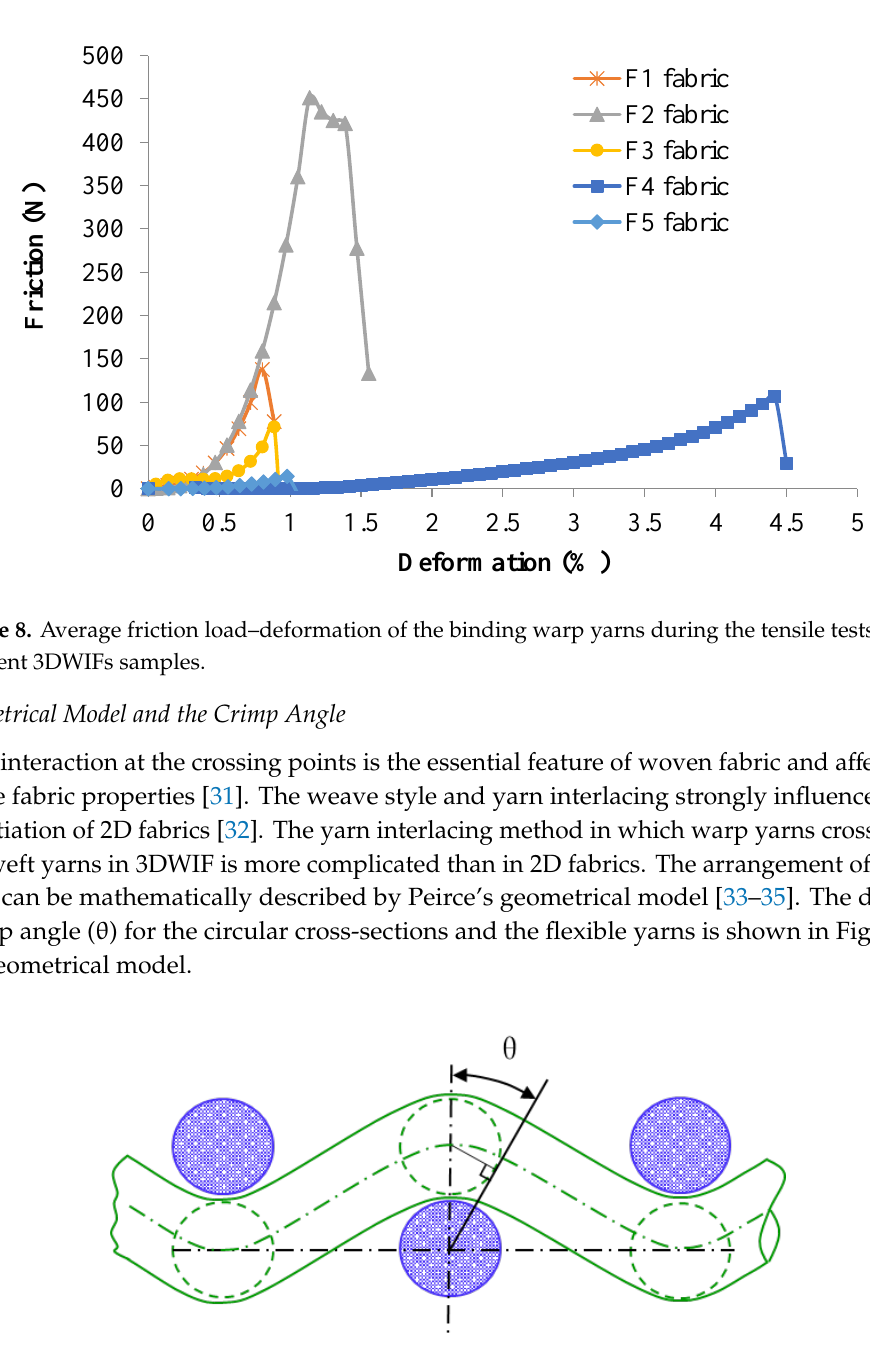
Figure 9. Definition of yarn crimp angle ( θ ) by using Peirce’s geometrical model of plain woven fabric.